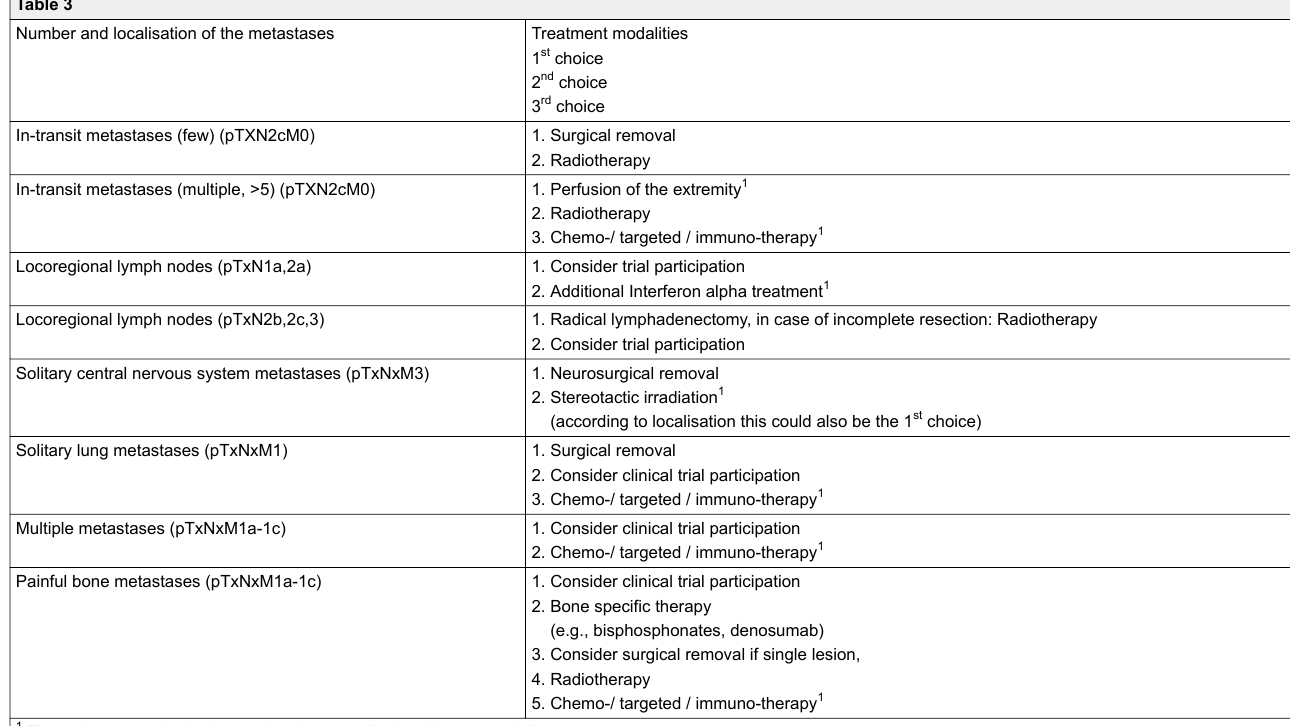
1 st choice 2 nd choice 3 rd